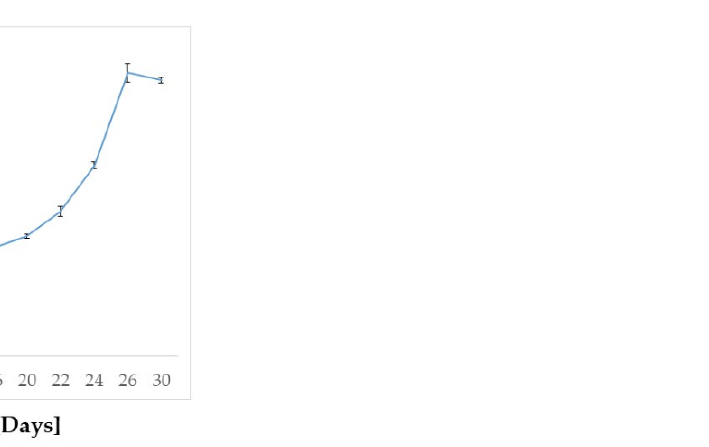
Figure 2. Batch growth of Amphidinium carterae LACW11 in f/2 medium monitored at λ = 600 nm.